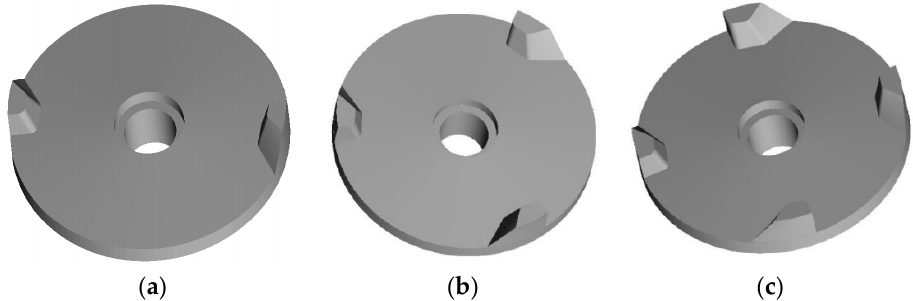
Figure 13. Moving cutter head with different numbers of cutter heads. ( a ) 2 cutter heads, ( b ) 3 cutter heads, ( c ) 4 cutter heads.